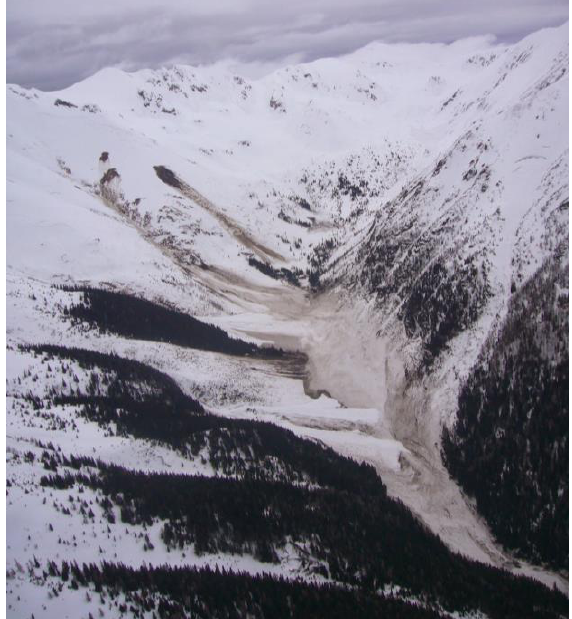
Figure 1: Avalanches in the Žiarska valley, photograph taken on April 1, 2009. Source: http://hzsslp.blogspot.sk/2014/03/5-